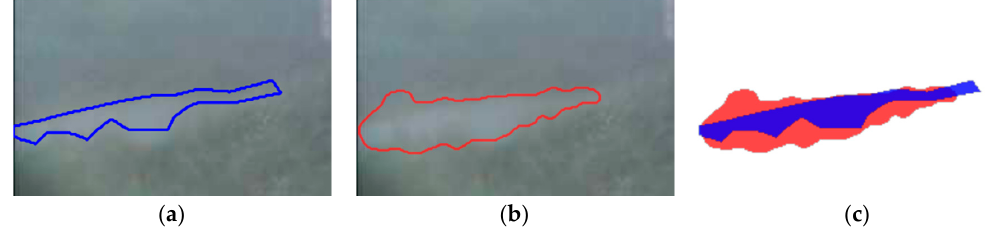
Figure 19. Example of a failed identification. The RegGro region (in red) overlaps with the ground truth (in blue). ( a ) ground truth; ( b ) RegGro region; and ( c ) comparison of regions.